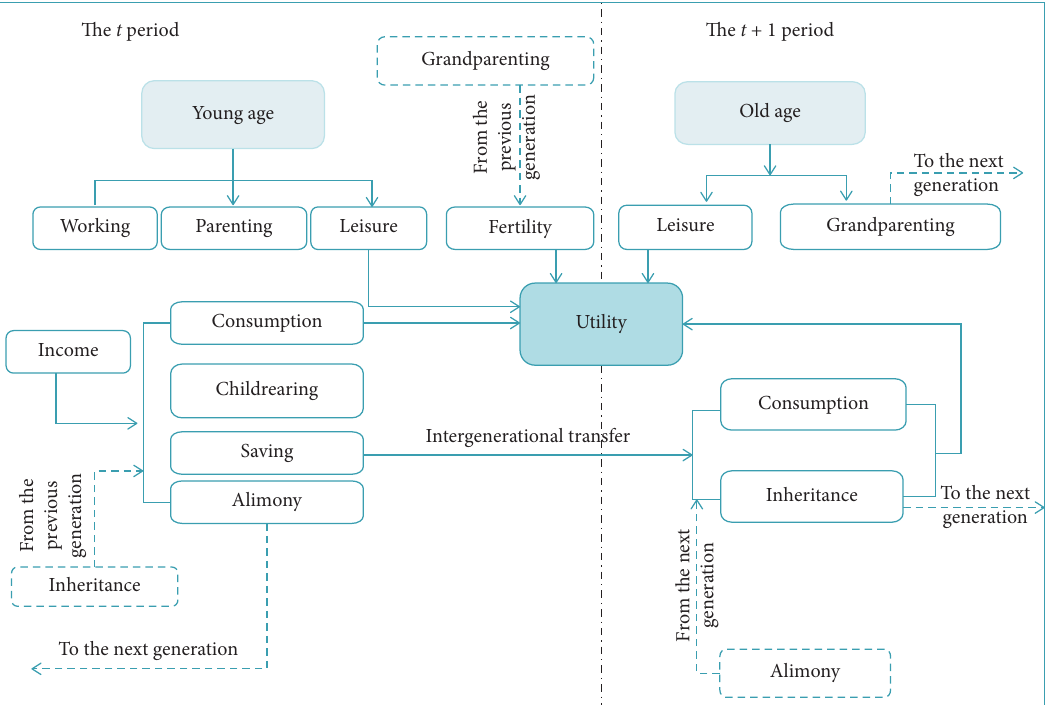
Figure 1: An overview of the structure of the developed OLG model for typical individuals. Intergenerational time and finical transfer, in the form of grandparenting, alimony, and inheritance, as well as intertemporal finical transfer, are